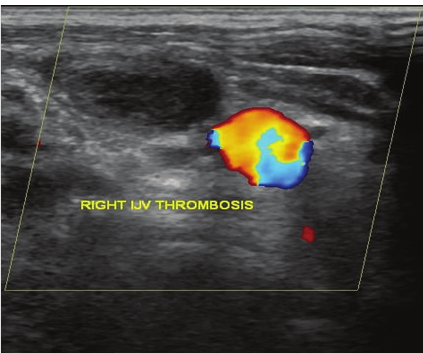
Figure 1: Doppler ultrasonography shows a thrombus in the right internal jugular vein.